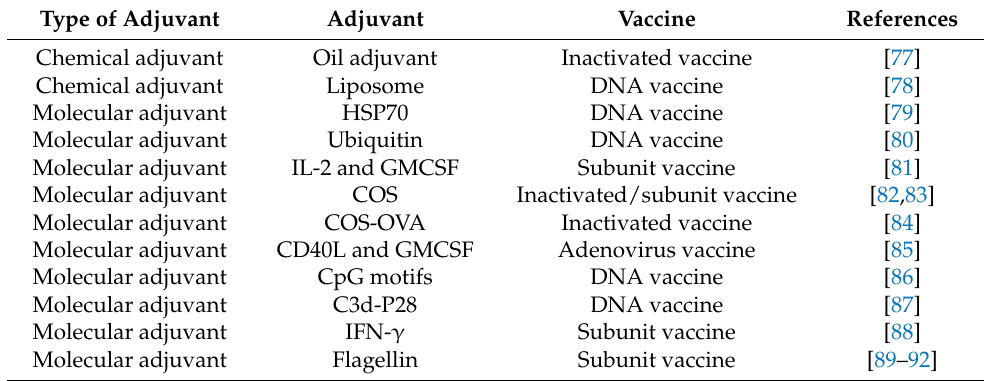
Table 1. Application of adjuvants in PCV2 experimental